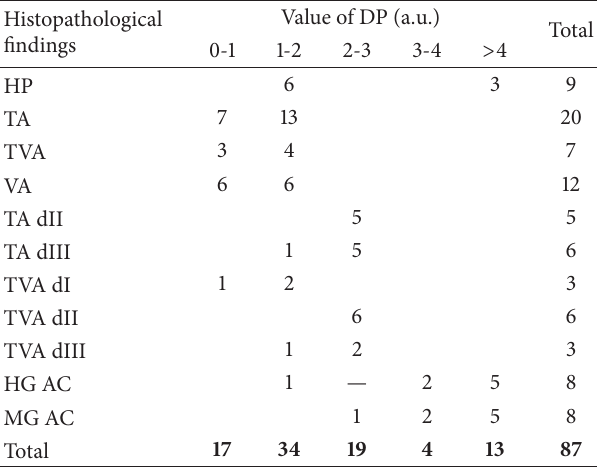
Table 2: Distribution of tumors depending on the diagnostic parameter (DP) and final histopathological findings.